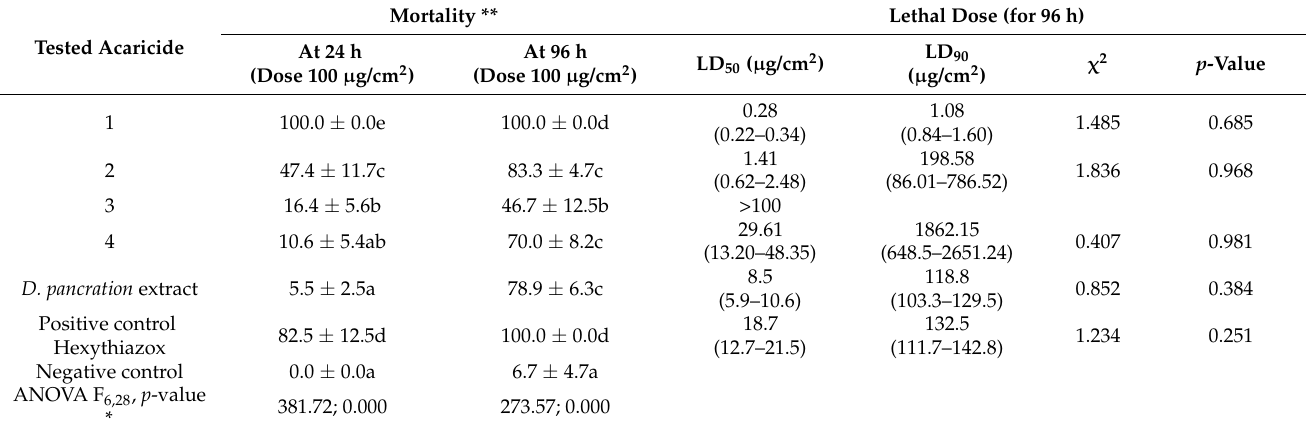
Table 1. Acaricidal effect of the isolated compounds and Drimia pancration extract against Tetranychus urticae females 96 h after application.